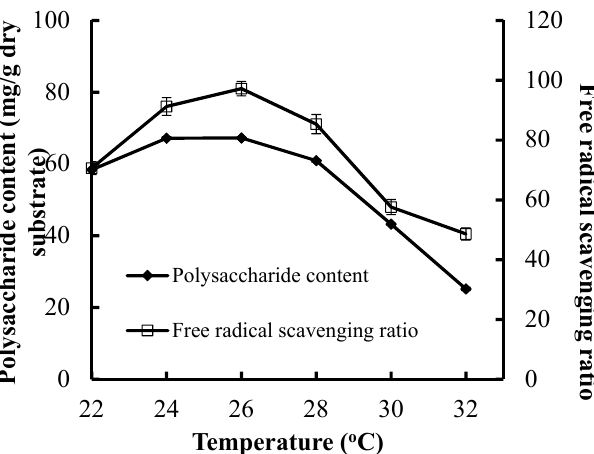
Figure 3. Effect of incubation temperature on CPS production and antioxidant activities of substrate.